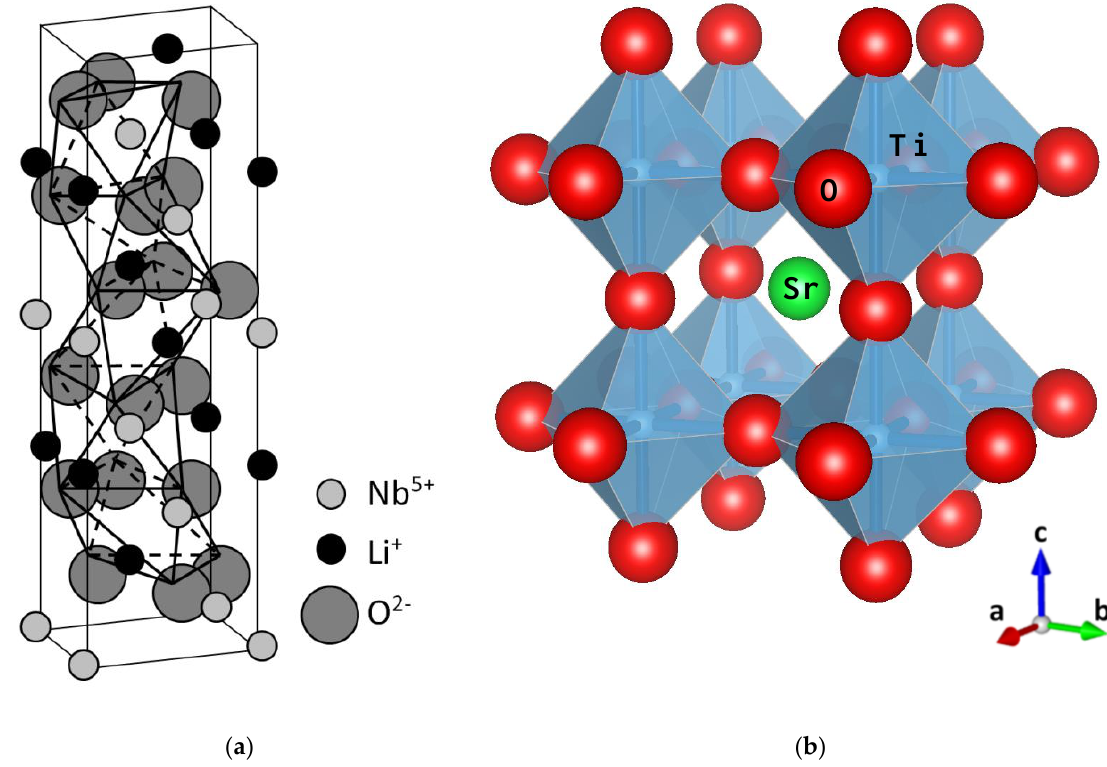
Figure 1. The trigonal ilmenite-like structure of LiNbO 3 ( a ), and the cubic perovskite structure of SrTiO 3 ( b ). Schematics show the stacking of oxygen octahedra. In ( a ), note the tilting (and rotation) of the octahedral units [NbO 6 ] along the c-axis. In ( b ), the [TiO 6 ] octahedral units are clearly observed. ( a ) has been adapted from Xue et al. [35], Copyright (2003), with permission from Elsevier; ( b ) was generated using Vesta software [36].